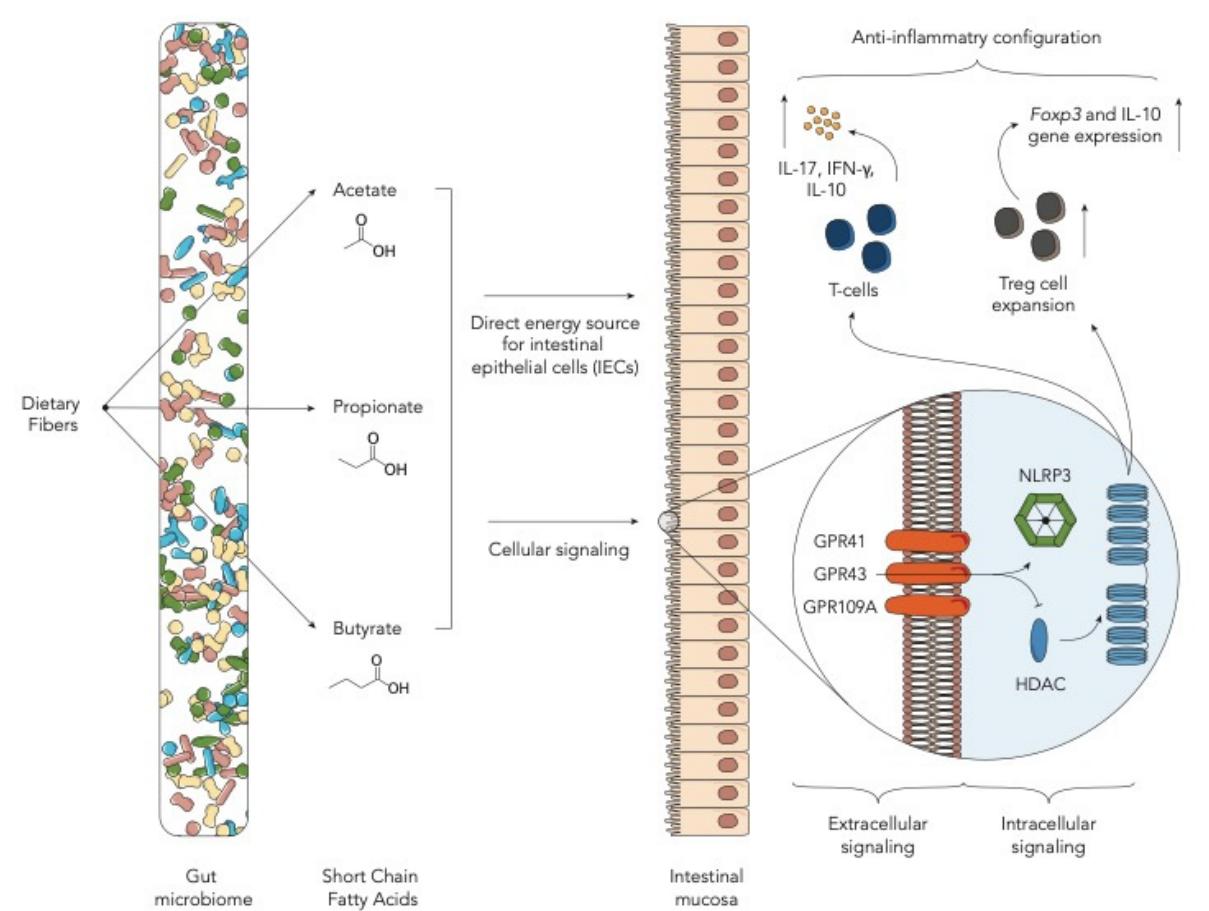
Figure 1. Schematic representation of the role of short chain fatty acids in the allogeneic hematopoietic stem cell transplantation (allo-HSCT) setting (HDAC—histone deacetylases; IEC—intestinal epithelial cells).